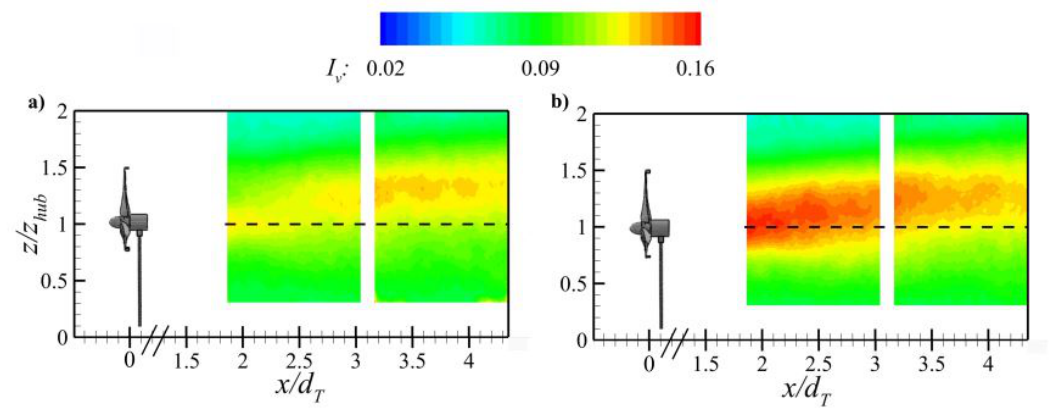
Figure 12. Normalized streamwise wake velocity fluctuation I v under α = ( a ) 0 ○ and ( b ) 90 ○